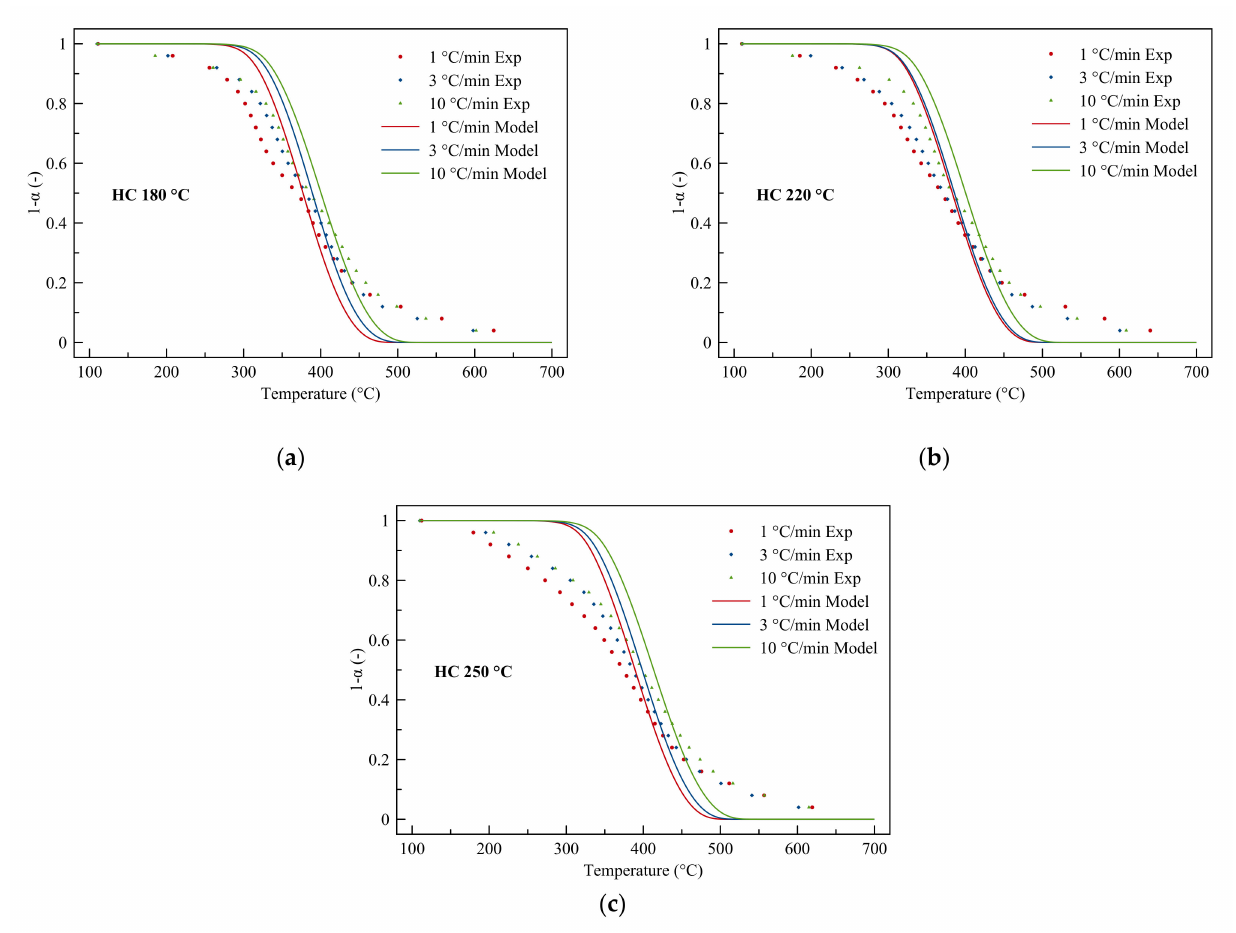
Figure 5. 1- α vs. temperature: comparison between experimental data (dots) and predicted data (lines) computed through the Gaussian model, during pyrolysis of different samples. ( a ) hydrochar 180 ◦ C; ( b ) hydrochar 220 ◦ C; ( c ) hydrochar 250 ◦